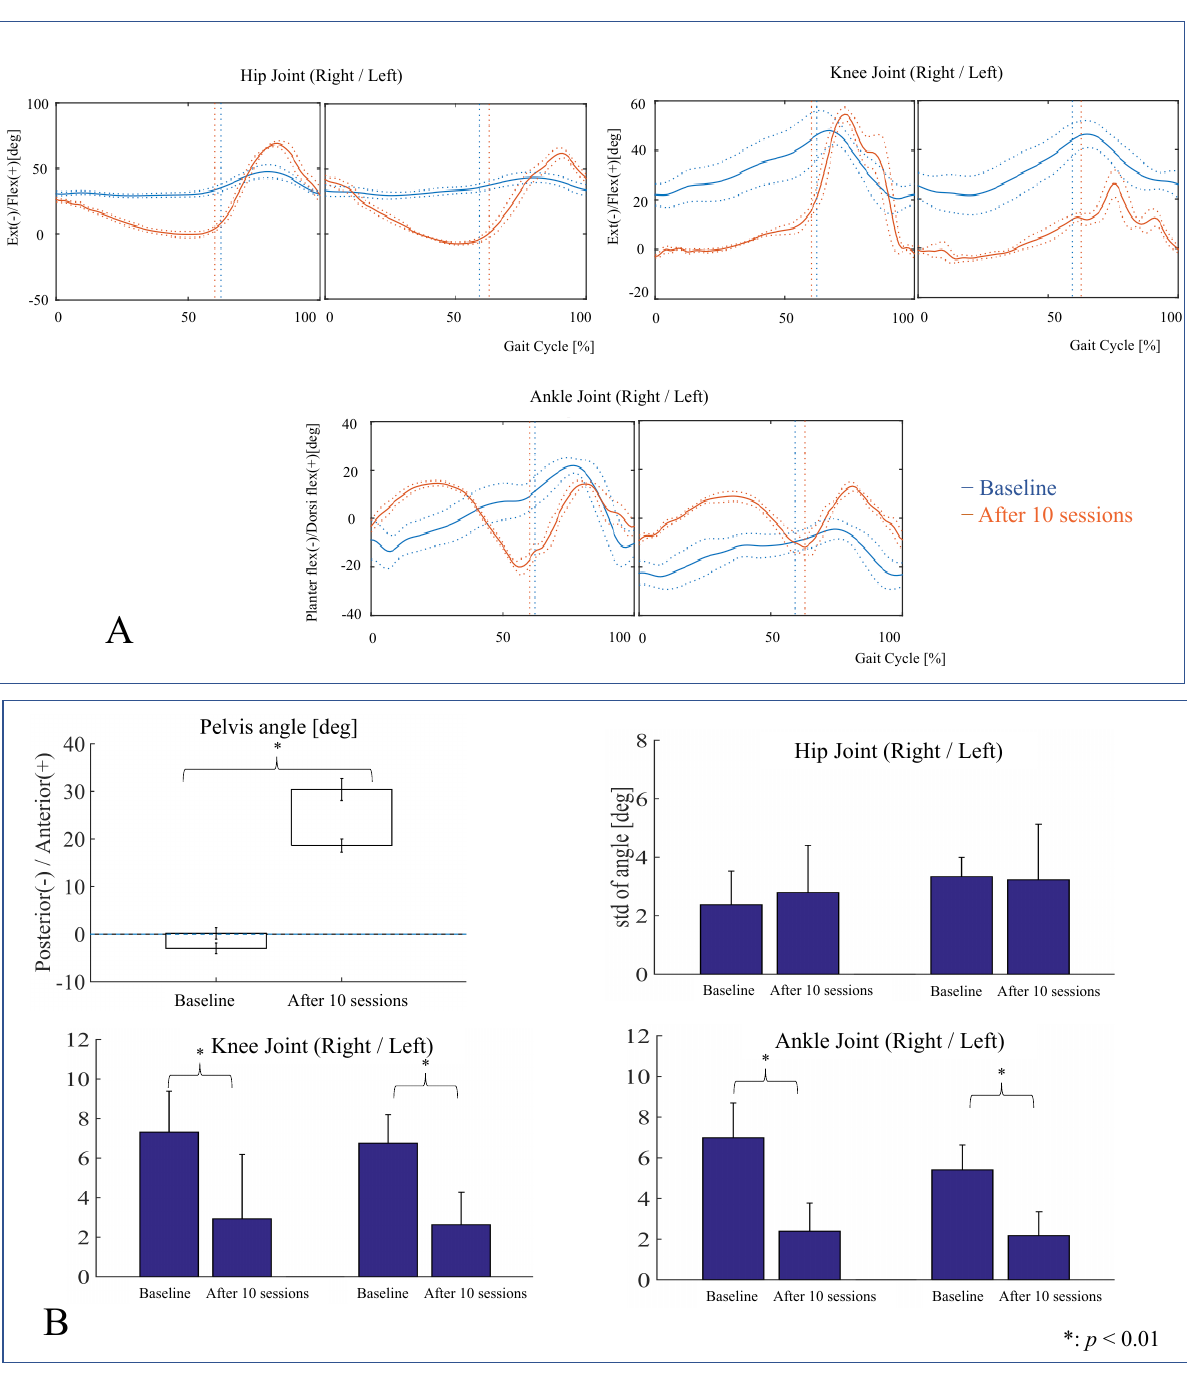
(baseline, right, 2.38; left, 3.34; after 10 sessions, right, 2.79; p < 0.03589, left, 3.23; p < 0.5926) (Figure 2B). Lower limb muscle activation during the gait cycle was rarely observed before HAL gait training. However, after HAL gait training, lower limb muscle activation during the gait cycle increased (Figure 2C).